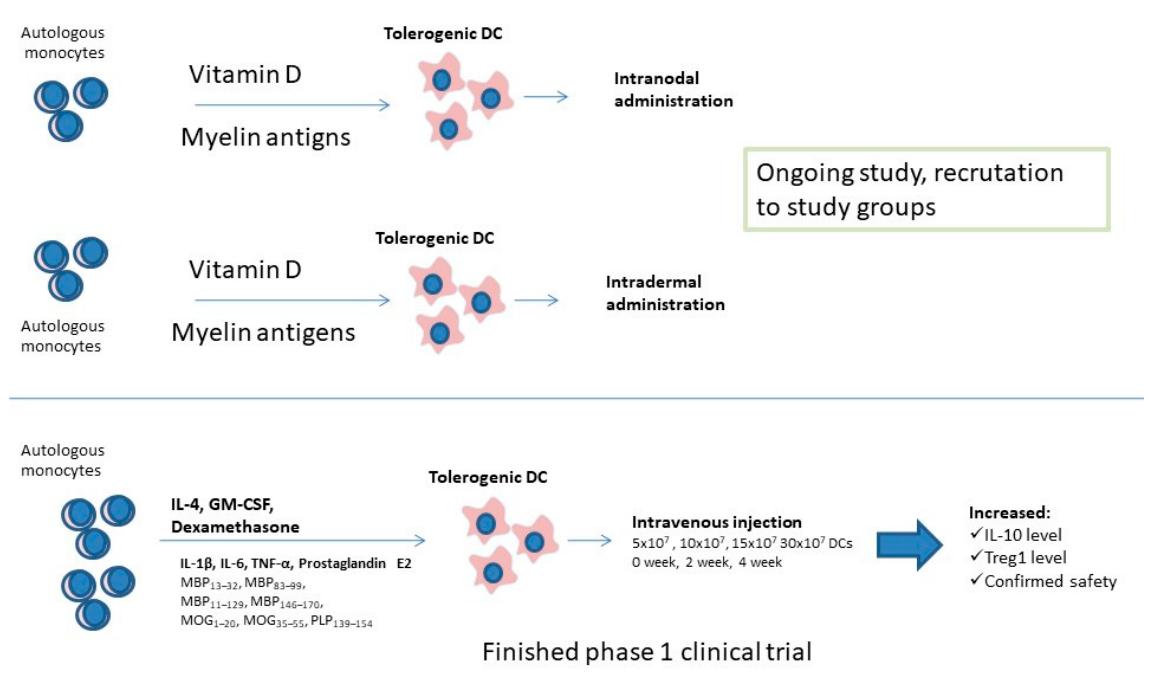
Figure 1. Clinical studies conducted on tolerogenic dendritic cells.